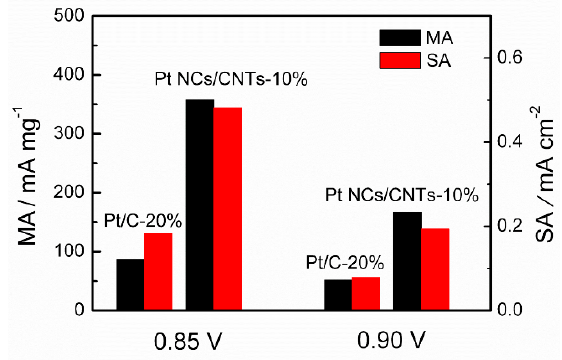
Figure 8. Mass activity (MA) and specific activity (SA) of Pt NCs/CNTs-10% and Pt/C-20% in 0.1 M HClO 4 at 0.85 V and 0.9